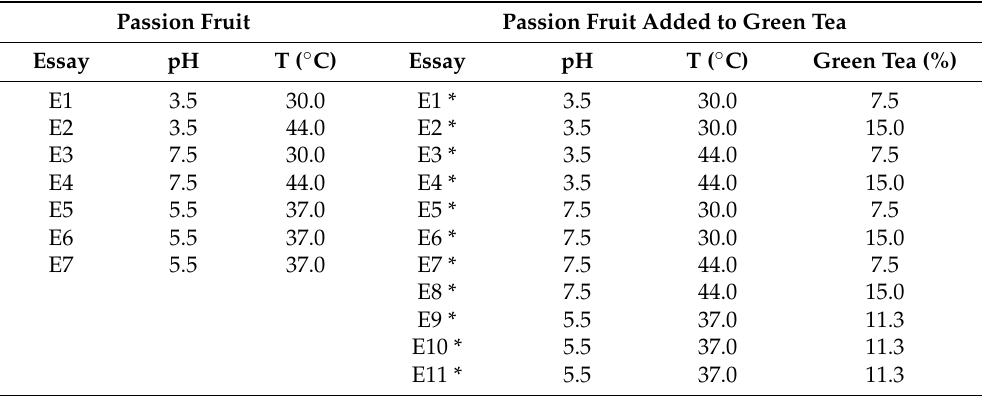
Table 1. Assay formulations based on full experimental